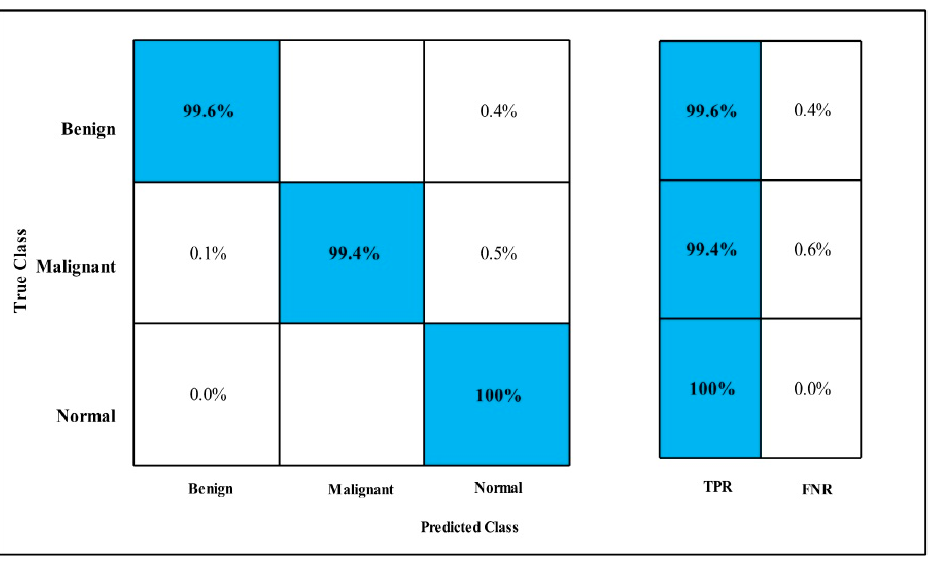
Table 13. Classification results using MEWOA on Fusion deep features for